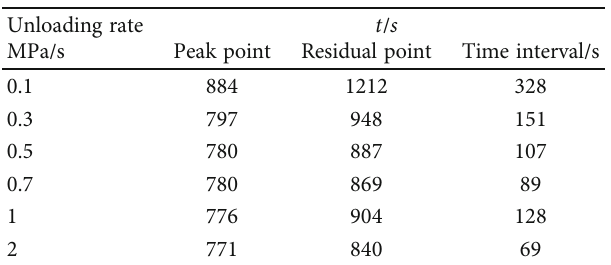
Figure 2: The relationship between strain energy at unloading point, peak point, and residual point and con fi ning pressure under triaxial loading and unloading conditions. Note: in the fi gure, p represents the peak point, r represents the residual point, and o represents the unloading point. Table 5: The time it takes to increase the dissipation energy of the residual stage at di ff erent unloading